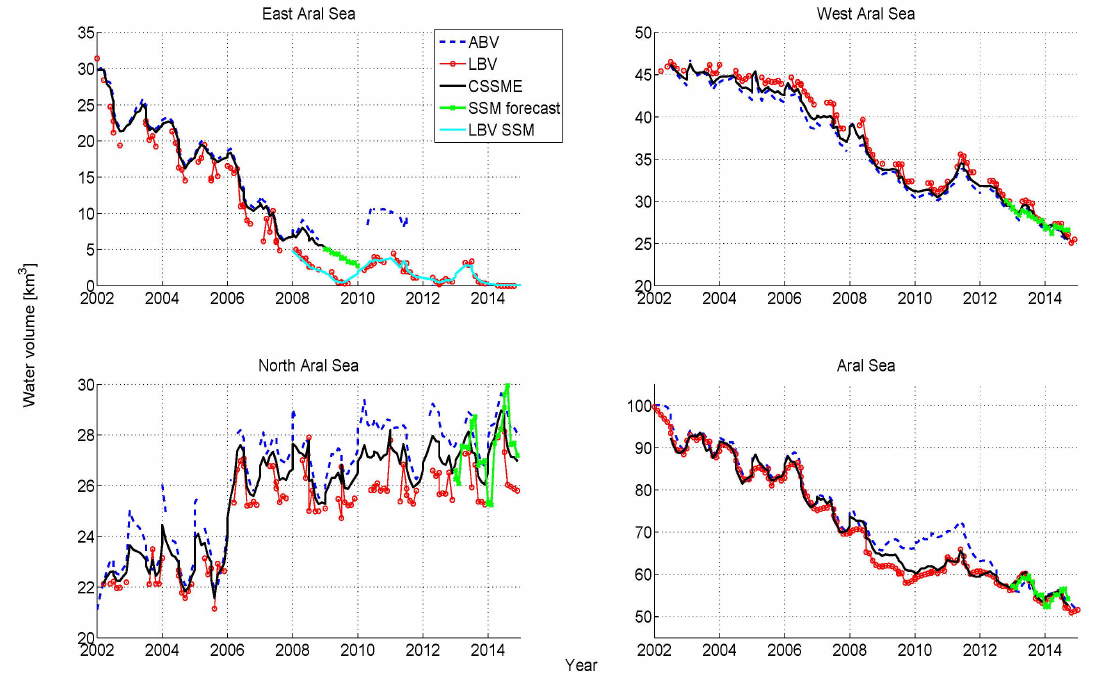
Figure 11. Aral Sea absolute volume (ABV and LBV), Combined SSM estimates, and SSM